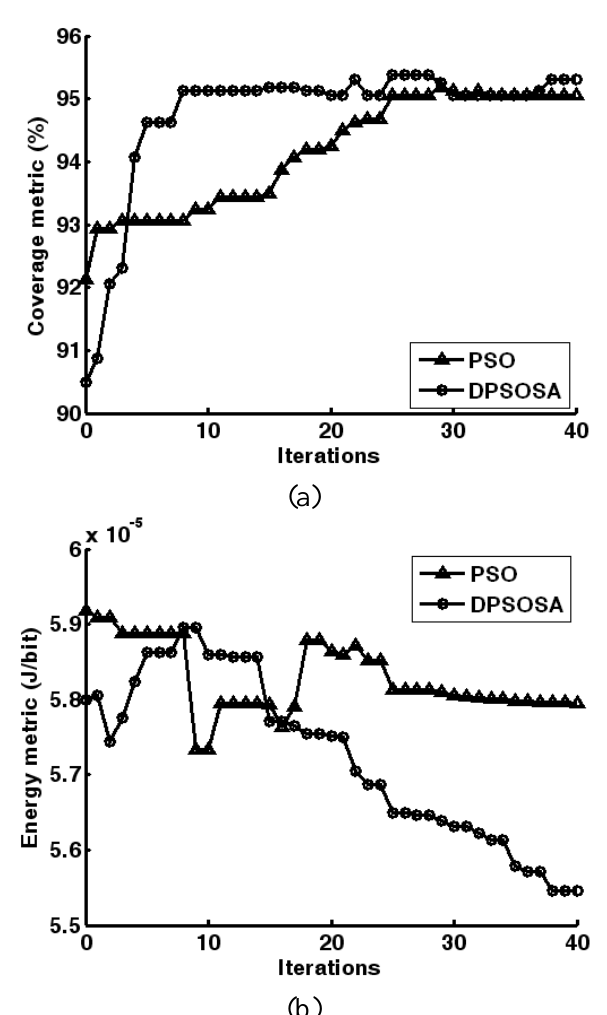
= 95%: (a) Coverage metric; (b) Energy 0